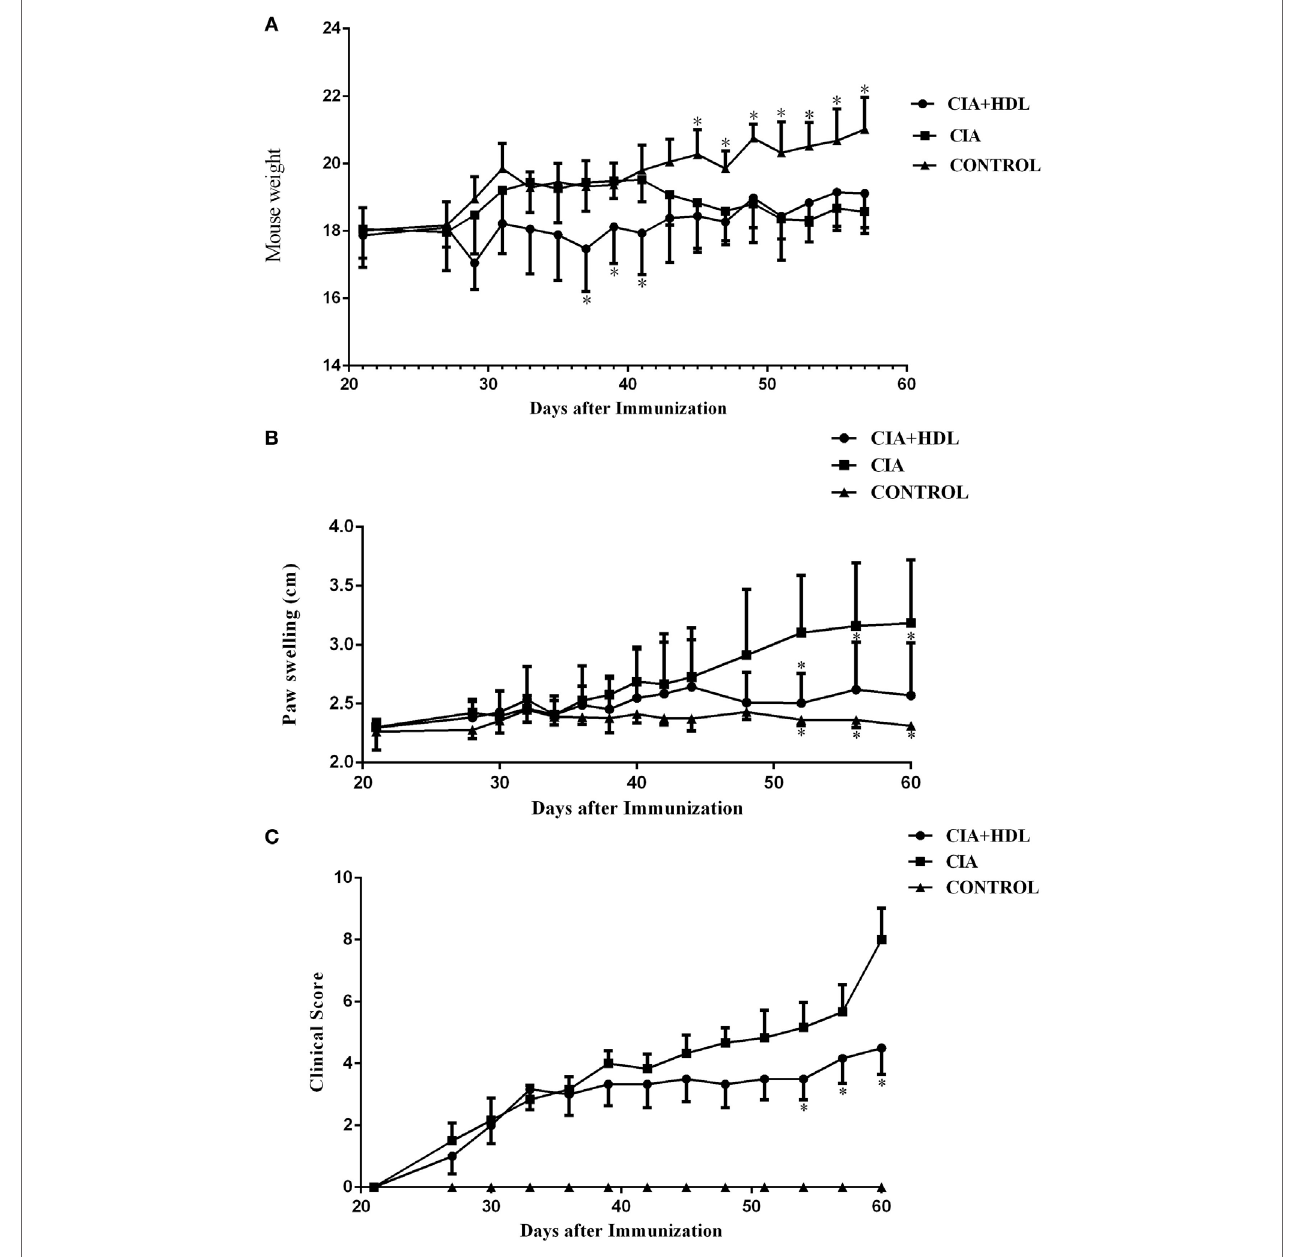
FigUre 1 | (a) Change of body weight in mice; (B) degree of paw swelling; (c) clinical score of arthritis. The body weight of the collagen-induced arthritis (CIA) + high-density lipoprotein (HDL) group decreased after HDL injection while later increased gradually to a value higher than the body weight of CIA group after day 49. The paw swelling of the mice in CIA + HDL group began to decrease after day 44; however, the CIA group was still increase. Compare with CIA group, the severity of arthritis score tended to decline after the injection of HDL. * p < 0.05 vs.